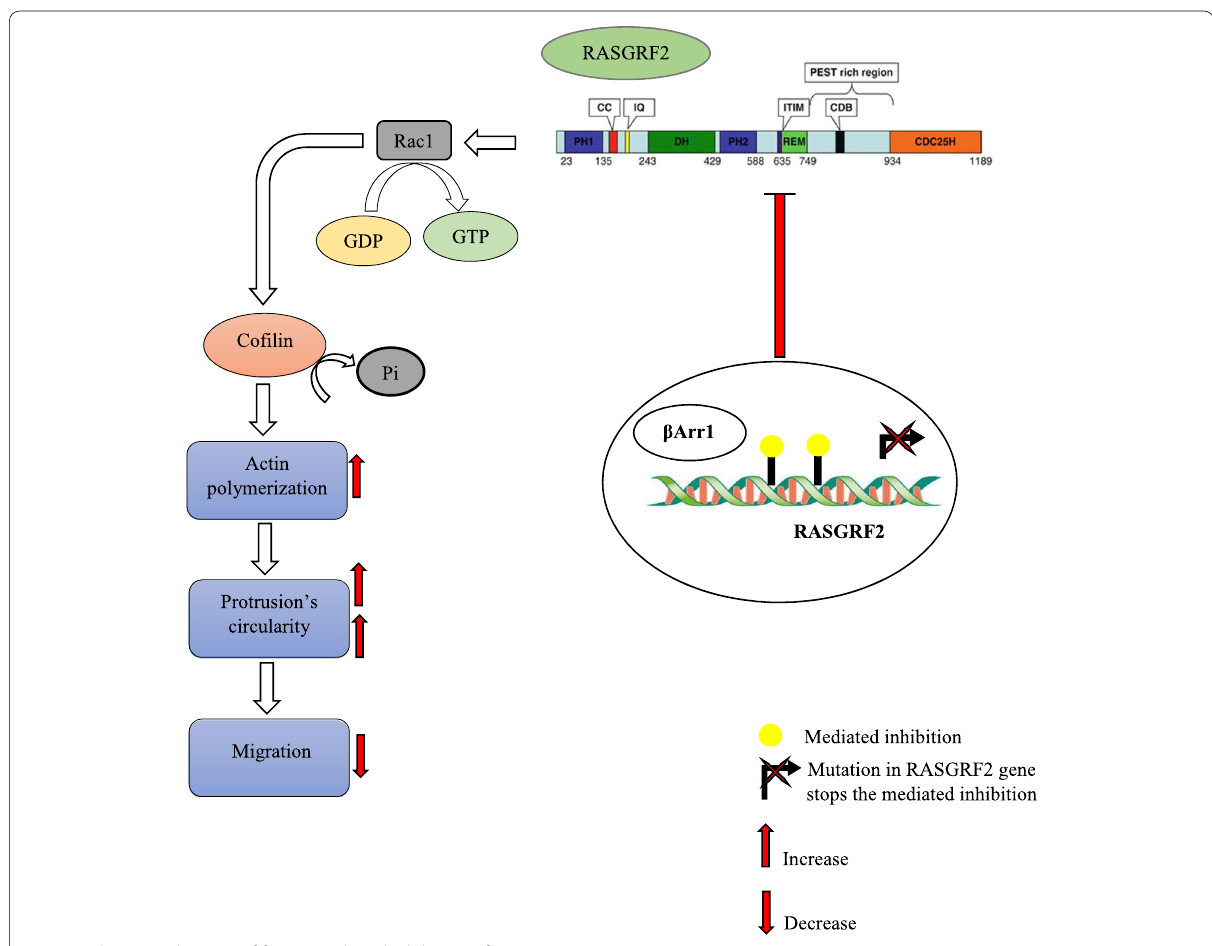
Fig. 3 Schematic diagram of βArr1-mediated inhibition of RASGRF2 gene